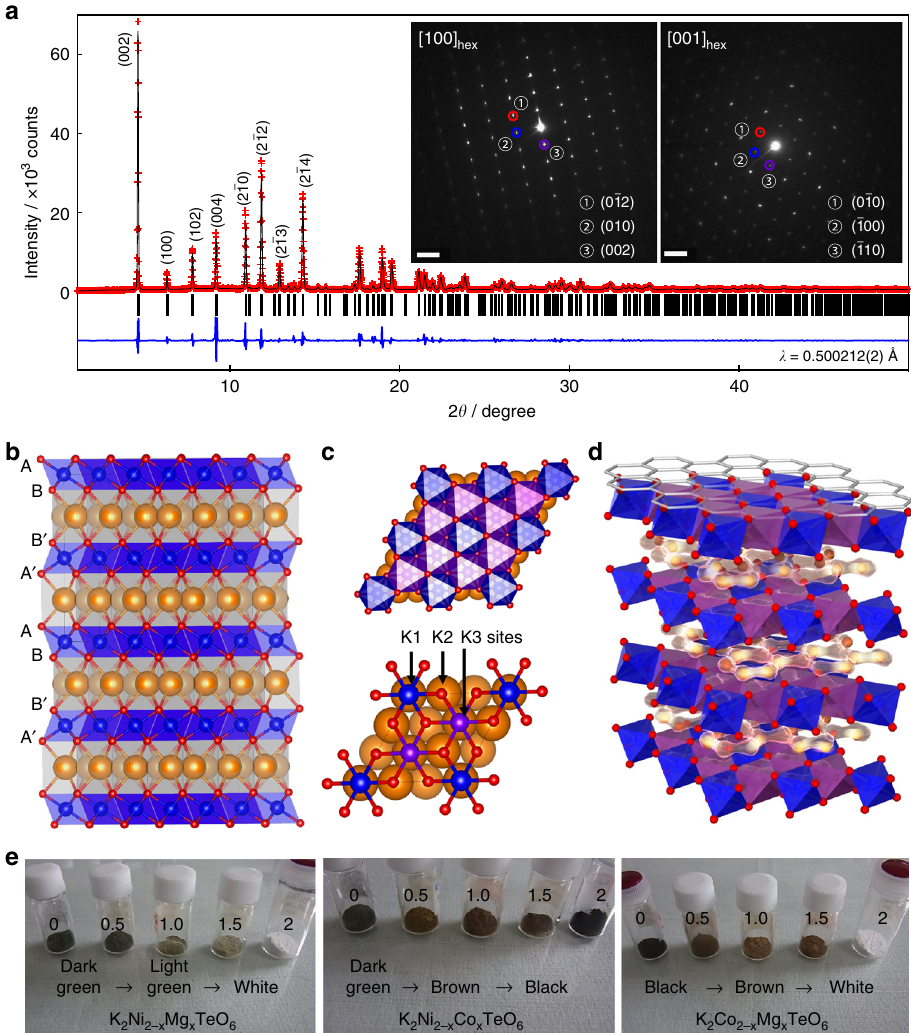
Fig. 1 Structural characterisation of honeycomb-layered K 2 Ni 2 TeO 6 and syntheses of related solid solution derivatives. a Rietveld re fi nement data of the synchrotron X-ray diffraction powder pattern of K 2 Ni 2 TeO 6 indexed in the ordered P 6 3 / mcm hexagonal space group ( R B = 4.29%, χ 2 = 1.77; low reliability values indicate a satisfactory fi t). The calculated and experimental Bragg peaks are indicated in black and red, respectively. The deviation between the experimental and calculated intensity is shown in blue, whilst black ticks indicate the Bragg peaks position of the orthotellurate phase. Inset shows the corresponding SAED patterns along [100] and [001] zone axes. The scale bar shows the length scale in the reciprocal space (2 nm – 1 ). b Polyhedral view of the P2-type-layered crystal structure of K 2 Ni 2 TeO 6 along the c -axis: the Ni octahedra are shown in purple, Te octahedra are in blue, K ions are brown spheres and O ions are small red spheres. The prismatic polyhedra around the K ions are shown for simplicity. c A fragment of the P 6 3 / mcm structure of K 2 Ni 2 TeO 6 in the ab plane (the magnetoactive honeycomb layers) with three major K sites (K1, K2, and K3). d 2D bond valency energy landscape (BVEL) map of K 2 Ni 2 TeO 6 with isosurfaces (yellow) of 0.35 eV for K. e Solid solution derivatives of K 2 Ni 2 TeO 6 showing colour evolution with different 3 d